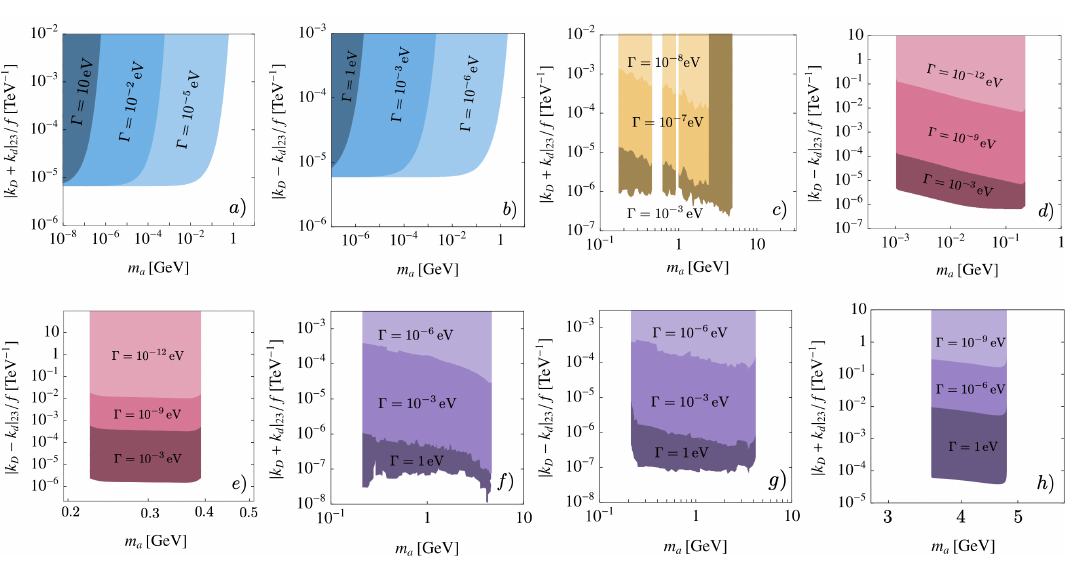
Figure 9 . Constraints on the flavor-violating ALP couplings [ k d ] 23 and [ k D ] 23 from B meson decays, collected in table 1, for different values of the total ALP width. The color-coding indicates the final state: blue for invisible final states, yellow for ALP decays into photons, red for a → e + e − decays and purple for a → µ − µ + and a → τ + τ − decays. The different contours in panel c) and f) are the result of the experiments providing different constraints depending on the ALP